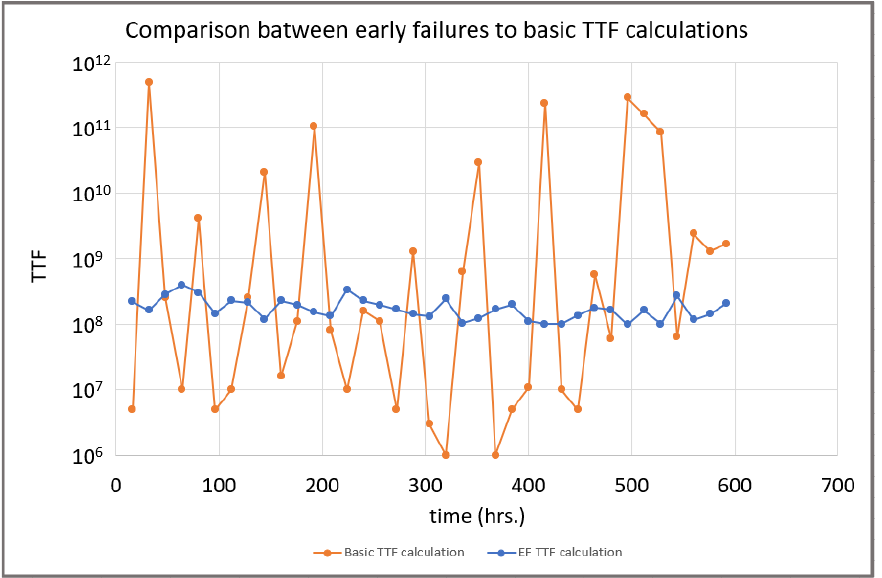
Figure 9. A comparison of measurement data between MHM testing, with noise reduction and with- out.